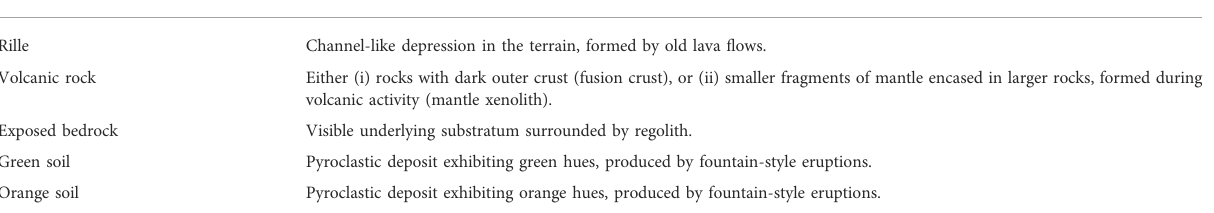
TABLE 1 List of novelties used in Lunar Analogue dataset. Novelty